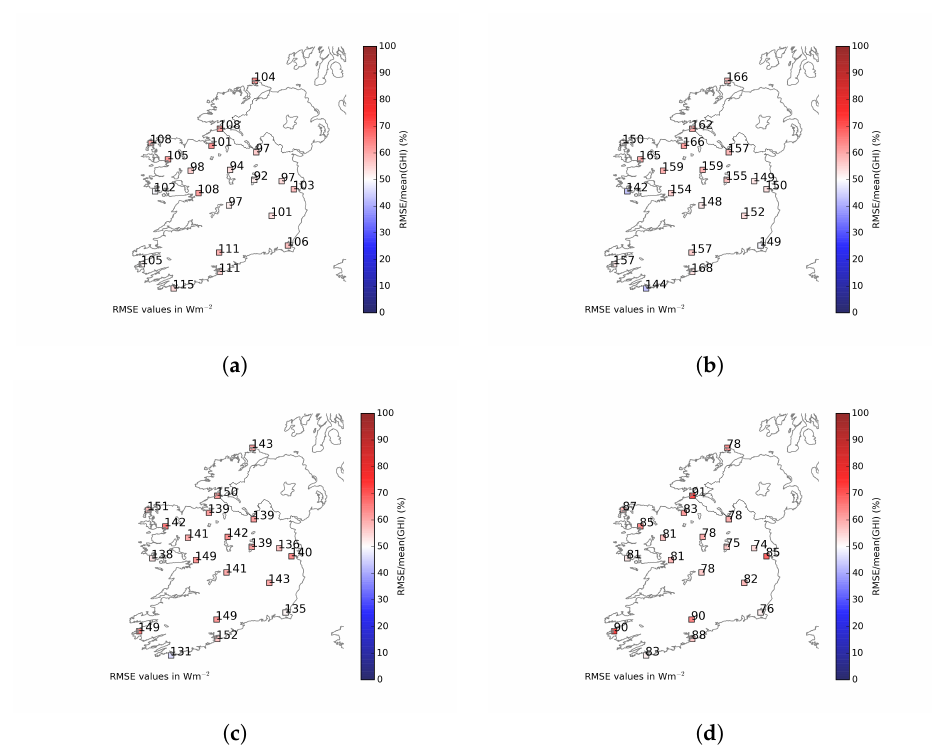
Figure 6. Monthly mean RMSE. The colours show the RMSE scaled by monthly mean GHI (%) for ( a ) March ( b ) June ( c ) August and ( d ) October using observations and MÉRA data for the period 2008 to 2014. The RMSE in Wm − 2 are marked on the plot.